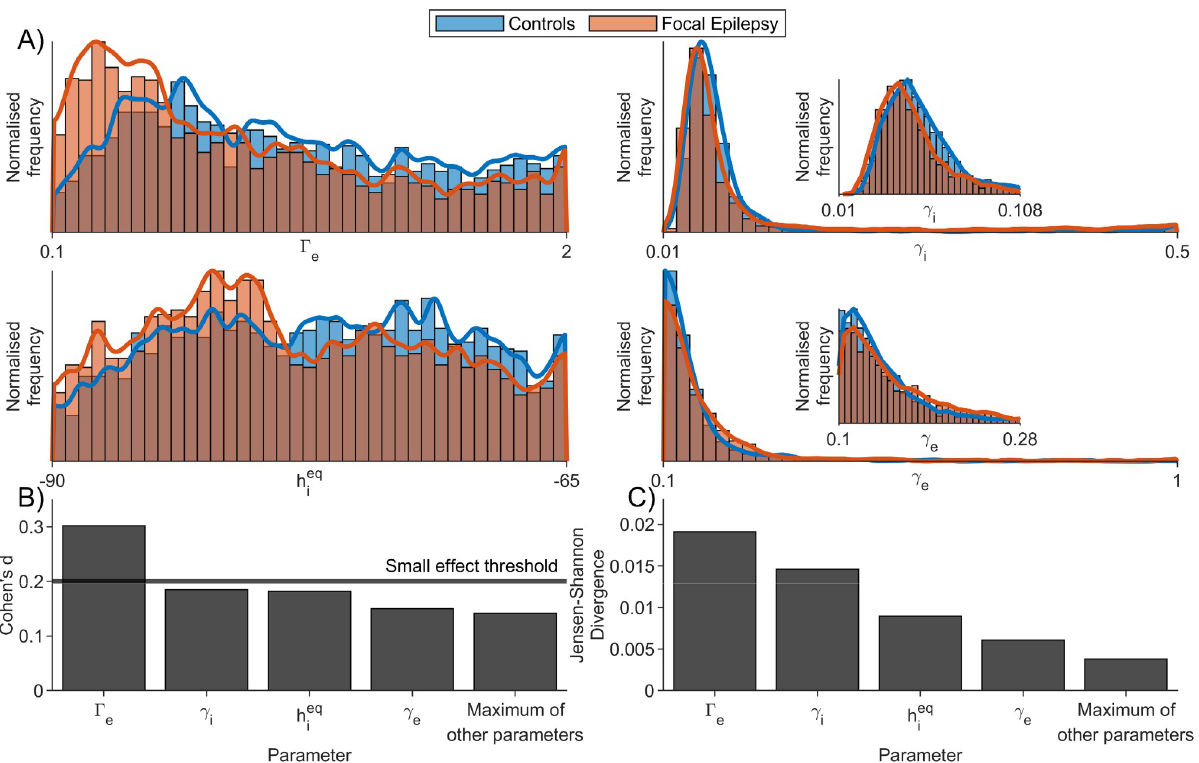
Fig 11. Comparison of parameter values recovered from control and FE data using the MOEA20 algorithm. A) shows the distribution of 4 parameters that were recovered from control and FE data (colours as per legend). The bounds of these parameters were set to those used in the optimisation (see Table 1). The 4 parameters chosen are those with the largest Cohen’s d effect size for differences between the groups, as shown in B). C) shows the JSD between the parameter distributions recovered from each cohort. This represents an alternative measure of dissimilarity between the distributions. The comparison between all parameters in the model can be seen in S15 Fig. The insets for parameters γ most populated part of the distributions, showing only the bottom 20% of each parameter range.